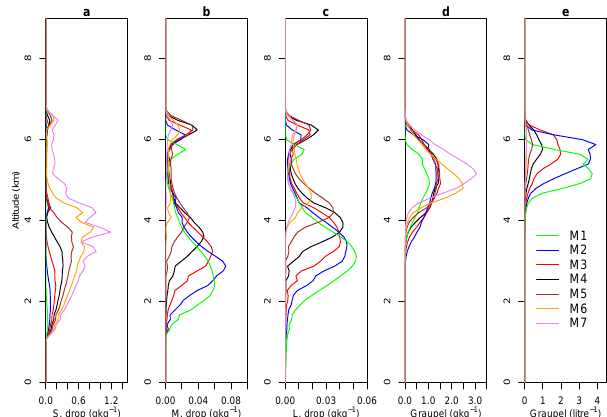
Fig. 13. Drop masses at the cloud centre for (a) small drops (diameter < 50µm), (b) medium-drops (50µm < diameter < 1000µm), and (c) large drops (diameter > 1000µm), Also shown are (d) mean graupel specific mass, and (e) graupel number concentration at 20min from TP-v2. See text for definitions. The mass and concentration of graupel are averaged over grid points where there is graupel.